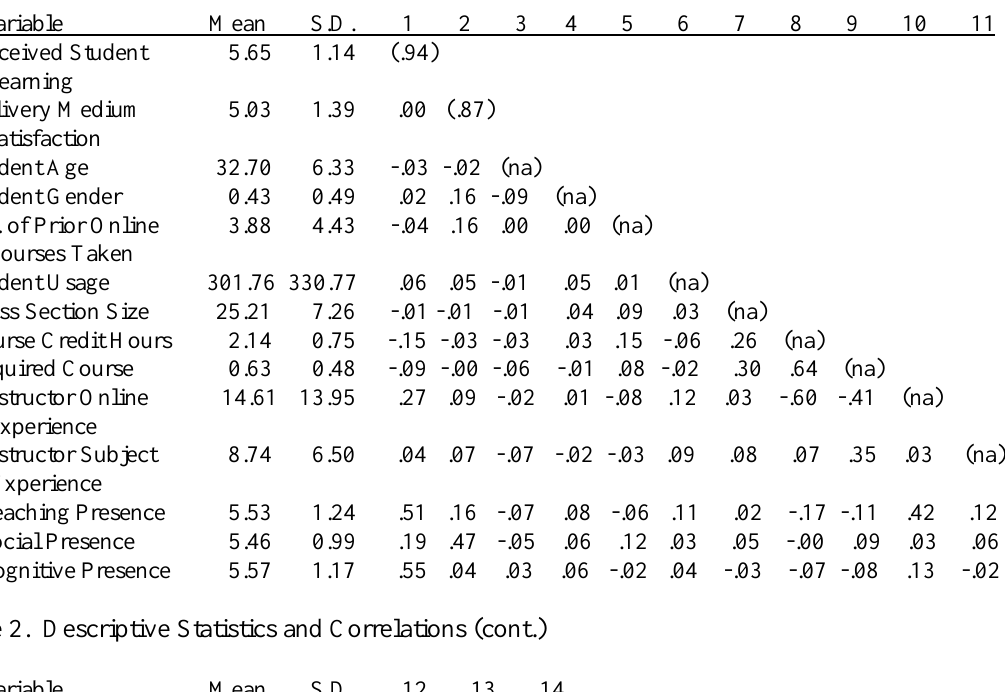
Table 2. Descriptive statistics and correlations